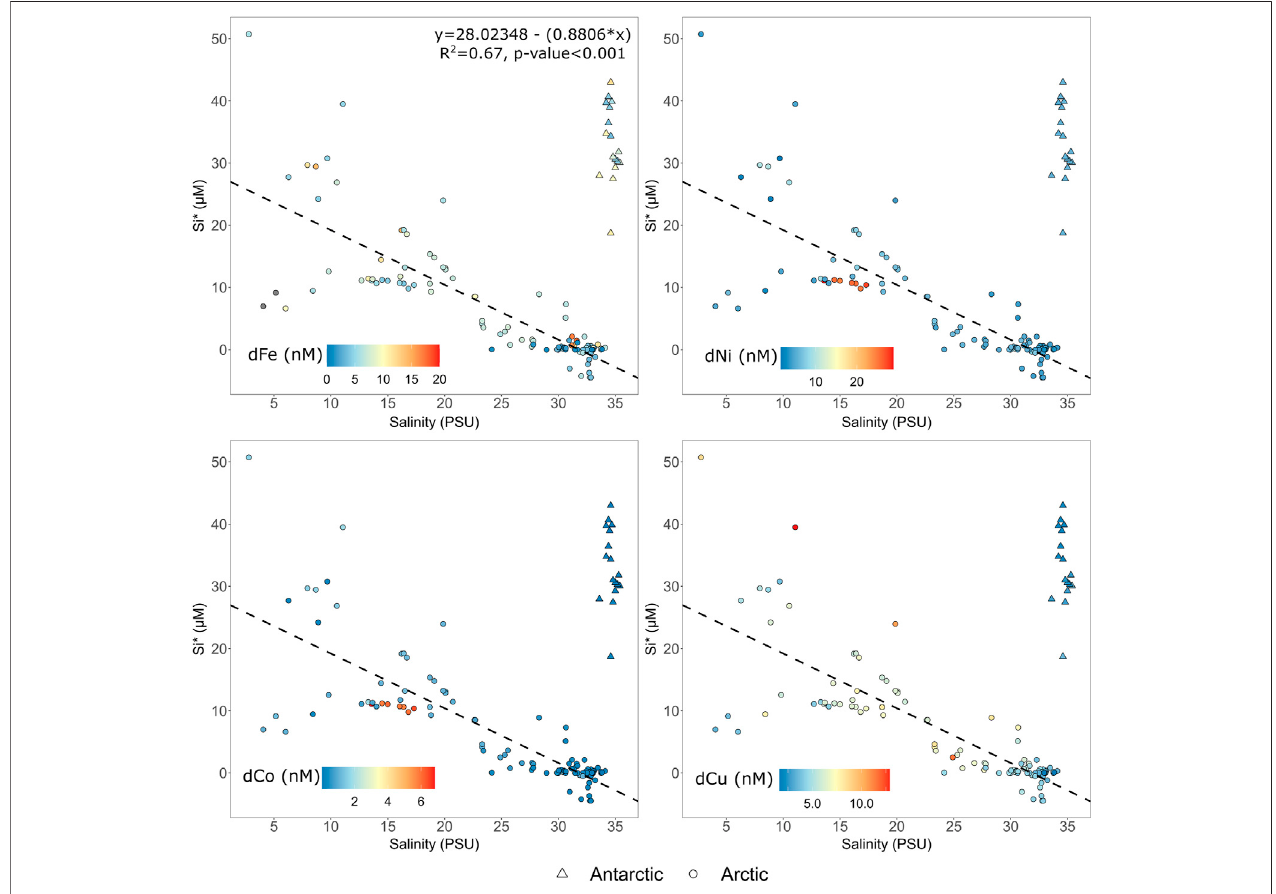
FIGURE 4 | Si* compared to dCo, dCu, dNi and dFe distributions (all nM) in all catchments. All data is plotted. The linear regression for Si* refers to Arctic (circles) data only. Antarctic (triangles) fi eld locations exhibit a different gradient due to the HNLC status of the Southern Ocean.